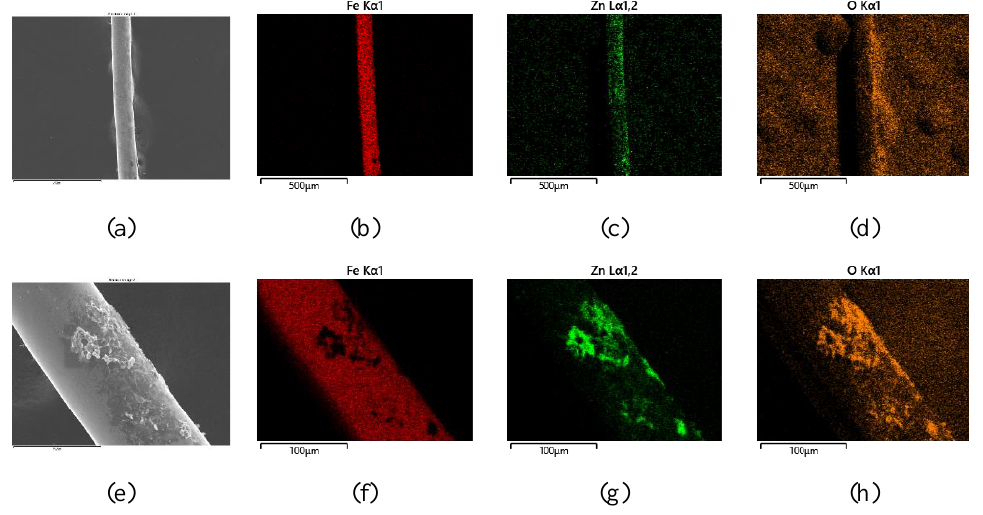
Figure 10. SEM-EDX analysis of the amorphous fibres coated via the hydrothermal technique using a precursor solution of 0.05 M concentration and a deposition duration of 6 h. ( a , e ) are SEM images of the plane and semi-circular surface of the fibres; ( b – d ) and ( f – h ) are distribution maps of the Fe, Zn and O on the plane and semi-circular surface of the fibres.